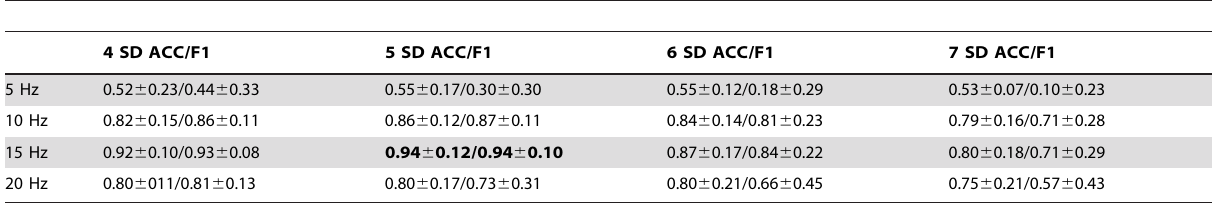
Table 2. Distribution of AAC and F1-scores across the participants (n=7) in various flickering frequencies and peak detection thresholds in terms of standard deviation (SD) of the baseline EEG signal.